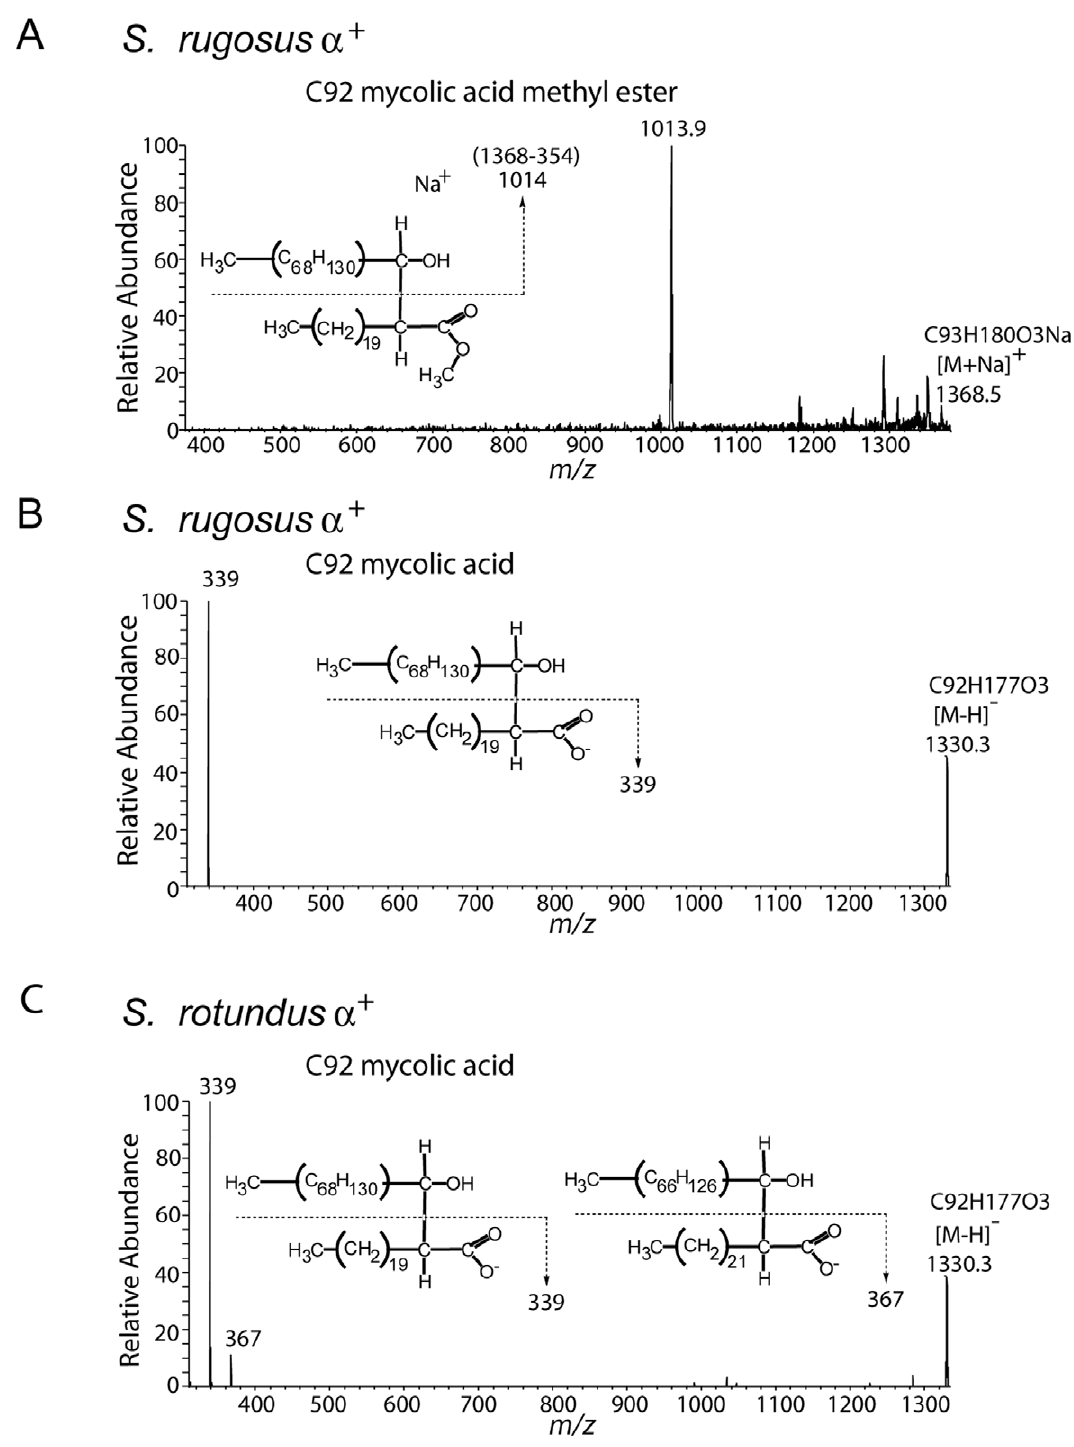
Figure 4. Collision induced dissociation mass spectrometry demonstrates alpha branch chain length. (A) Purified S. rugosus MAMEs found in the high migrating fraction on the TLC plate were dissolved in chloroform and methanol solution, loaded into a nanospray tip and analyzed by positive-ion mode electrospray ionization mass spectrometry with ion trapping. The ion at m/z 1368.5 [M + Na] + corresponding to C92 mycolic acid methyl ester was subjected to CID-MS, yielding a fragment ion corresponding to a sodium adduct of the meroaldehyde chain ( m/z 1013.9) which indicates a neutral loss of the a -chain-derived C22:0 methyl ester. (B–C) Bacterial pellets of S. rugosus and S. rotundus were extracted with chloroform, diluted with methanol and analyzed by negative-ion mode electrospray ionization mass spectrometry. Both samples contain an ion at m/z 1330.3 ([M-H] 2 ) corresponding to C92 mycolic acid, which was subjected to CID-MS analysis. The product ion 339 from S. rugosus (B) and ions 339 and 367 from S. rotundus (C) indicate the presence of C22:0 and C24:0 a -branch-derived fatty acids.